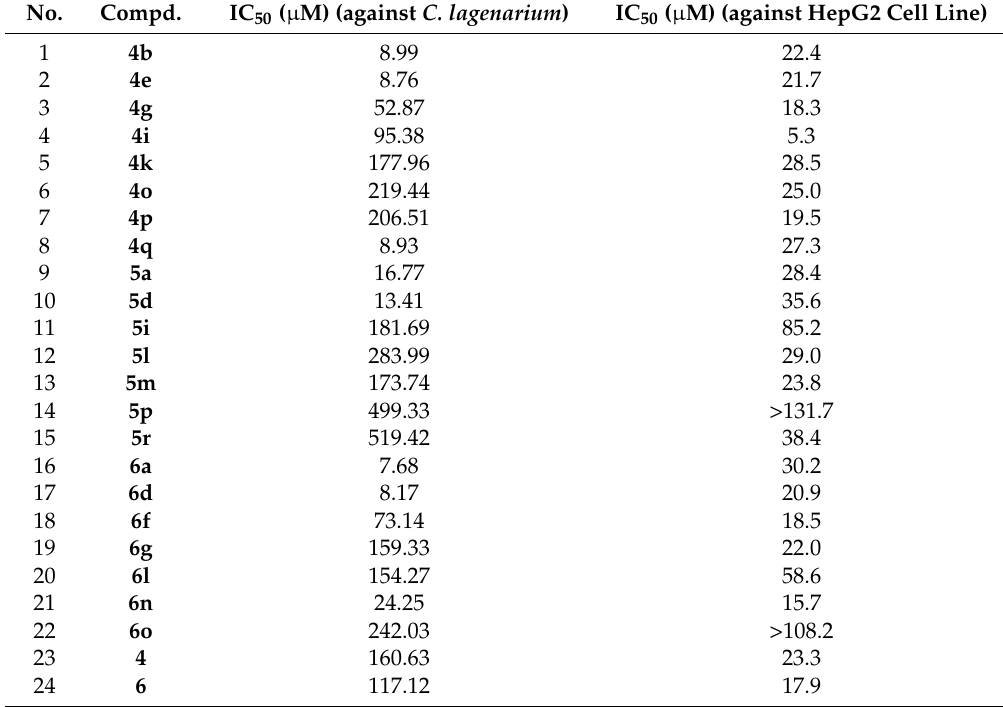
Table 6. In vitro fungicidal activity of compounds against C. lagenarium and cytotoxic activity against a human tumor cells line